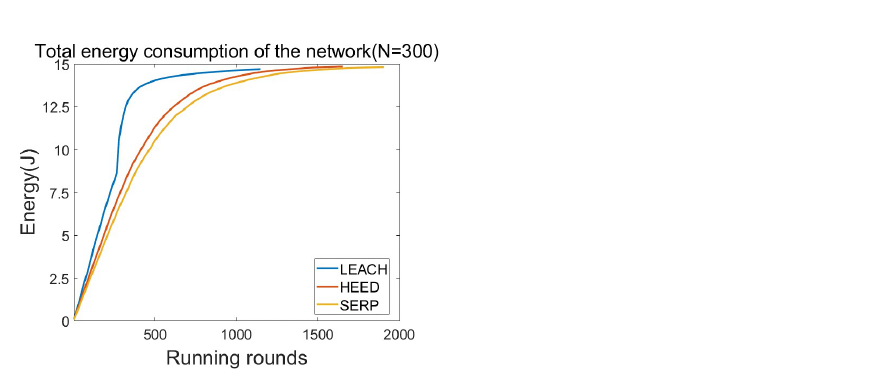
Figure 6. Total energy consumption of the network when the number of nodes N = 300.